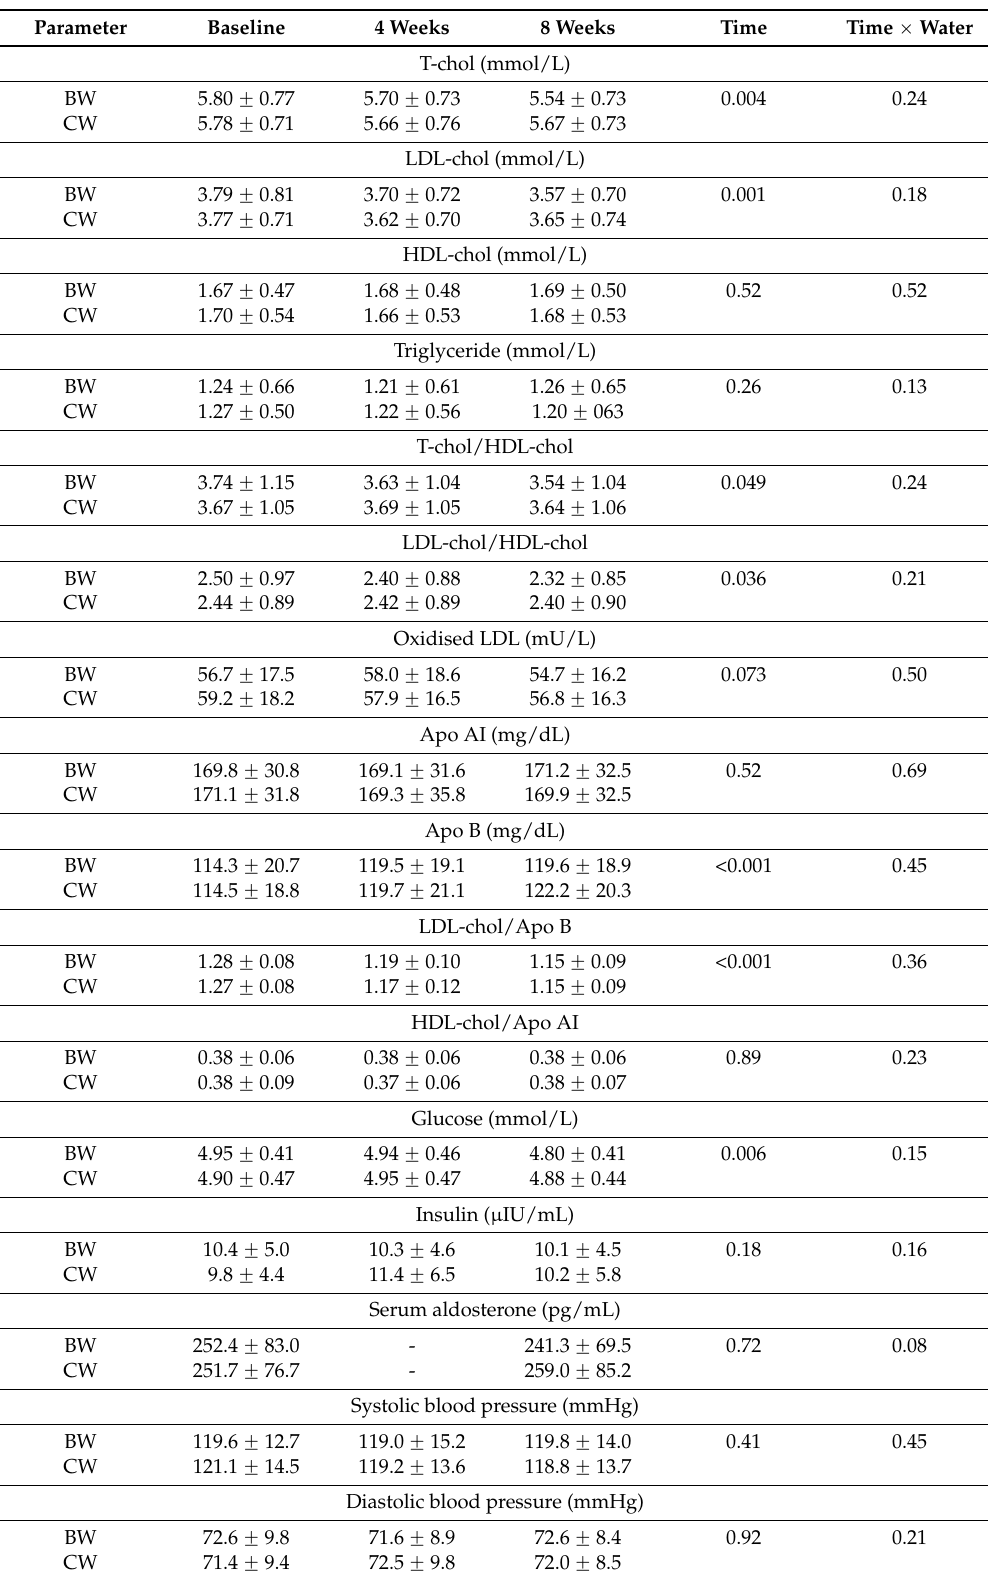
Table 2. Changes in cardiometabolic parameters of volunteers consuming bicarbonated water (BW) or control water (CW) for eight